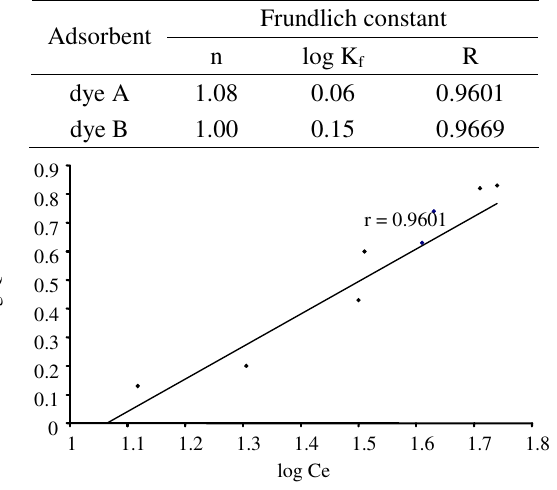
Figure 4. Freundlich isotherm of dye A with charcoal at pH